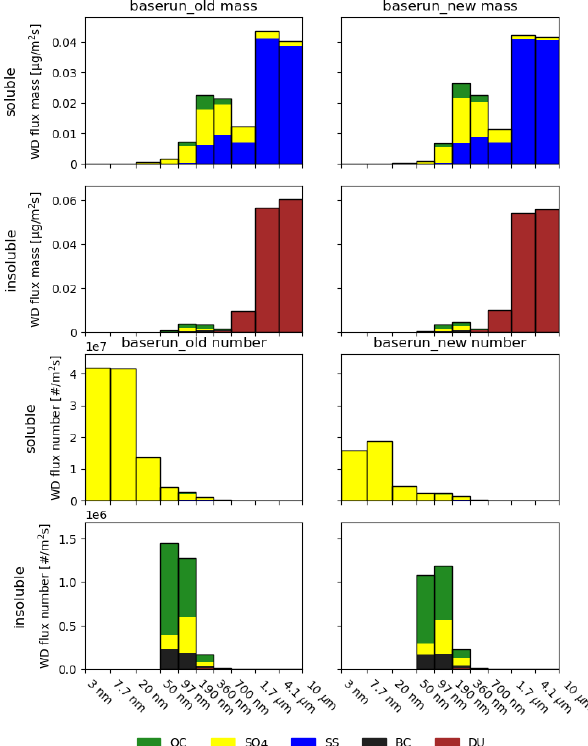
Figure 4. Wet deposition flux size distributions of different aerosol compounds simulated with old (left column) and current (right col- umn) in-cloud wet deposition schemes. The top four panels show the wet deposition flux for the mass distribution and the lower four for the number distribution. Different rows show values for the dif- ferent solubility